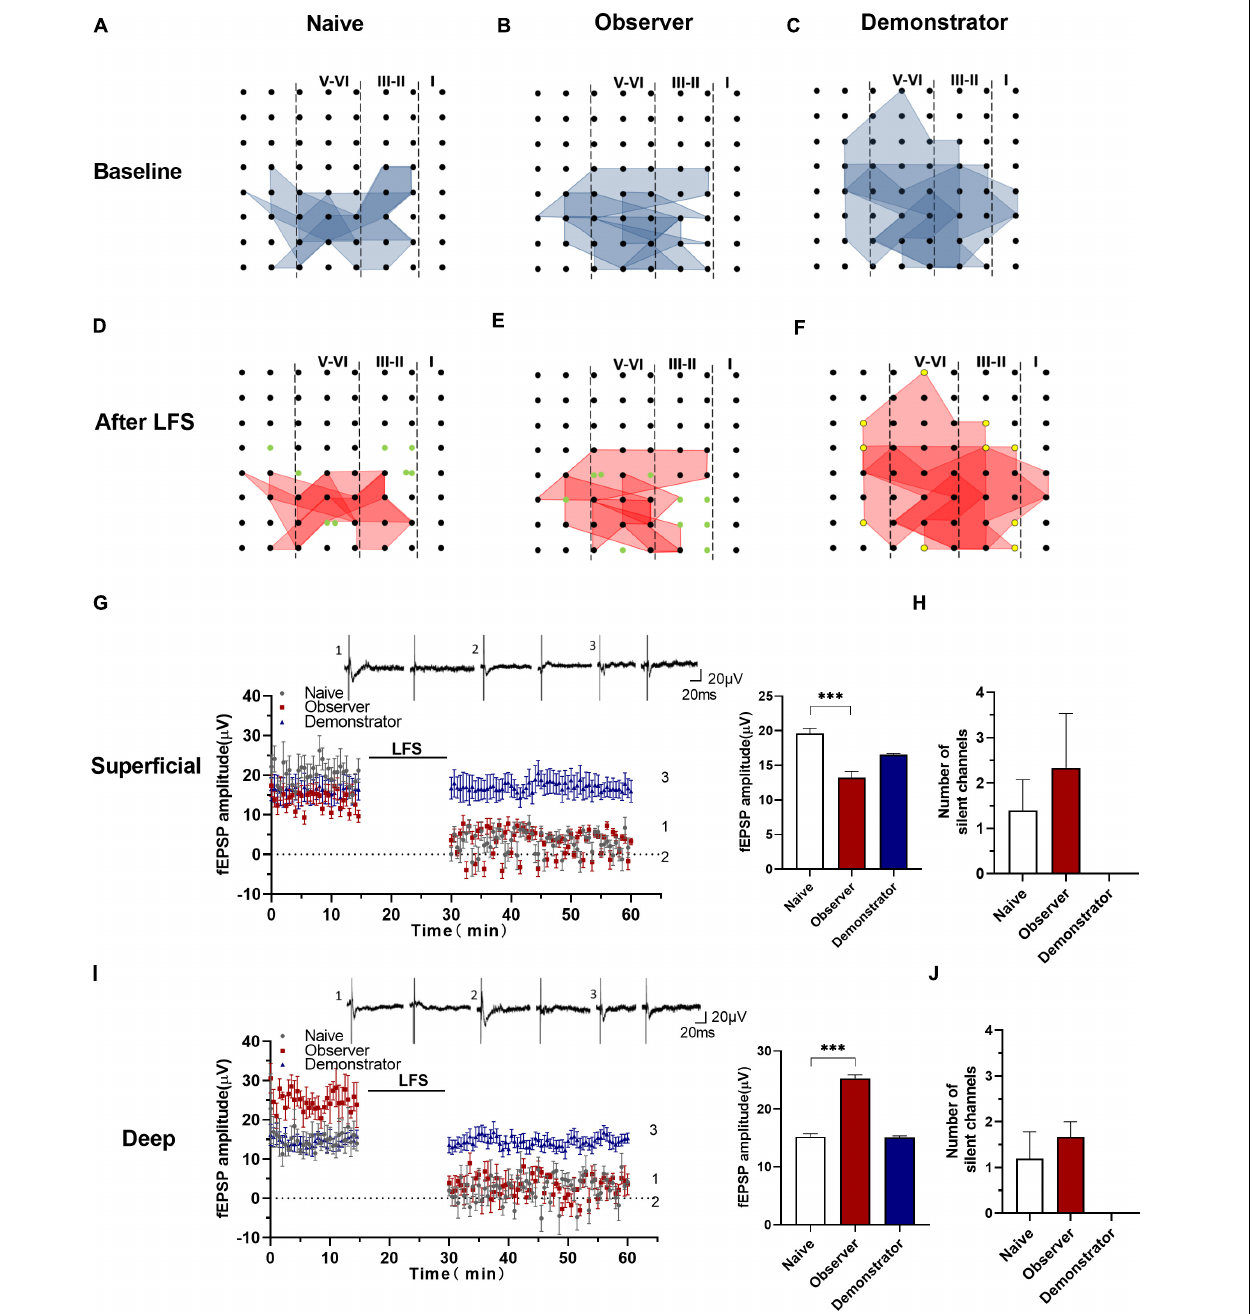
FIGURE 8 | Silencing responses after the induction of LTD in aIC. (A–F) The network propagation of synaptic responses in aIC of naïve (A,D) , observer (B,E) , and demonstrator mice (C,F) ; Basal-activated areas (blue) and recruited areas (red) and the silent channels are shown as green, the channels at the edge of the activated channels in demonstrator mice are shown as yellow spot; (G,I) Left: Time course of averaged fEPSP amplitude of silent channels from the superficial (G) and deep layers (I) in naïve and observer mice and the no responses channels in demonstrator mice. The line indicates the time of LFS application in the deep layer V/VI; Right: the average fEPSP amplitude of the channels within the last 10 min baseline recording in the superficial (G) and deep layers (I) . (H,J) Average number of silent channels of naïve, observer, and demonstrator mice in the superficial (H) and deep layers (J) . Data are shown as mean ± SEM (naïve n = 4 slices of 4 mice, observer n = 4 slices of 4 mice, and demonstrator n = 4 slices of 4 mice) and compared by unpaired t -test with Welch’s correction, ∗∗∗ p < 0.001, vs. naïve.